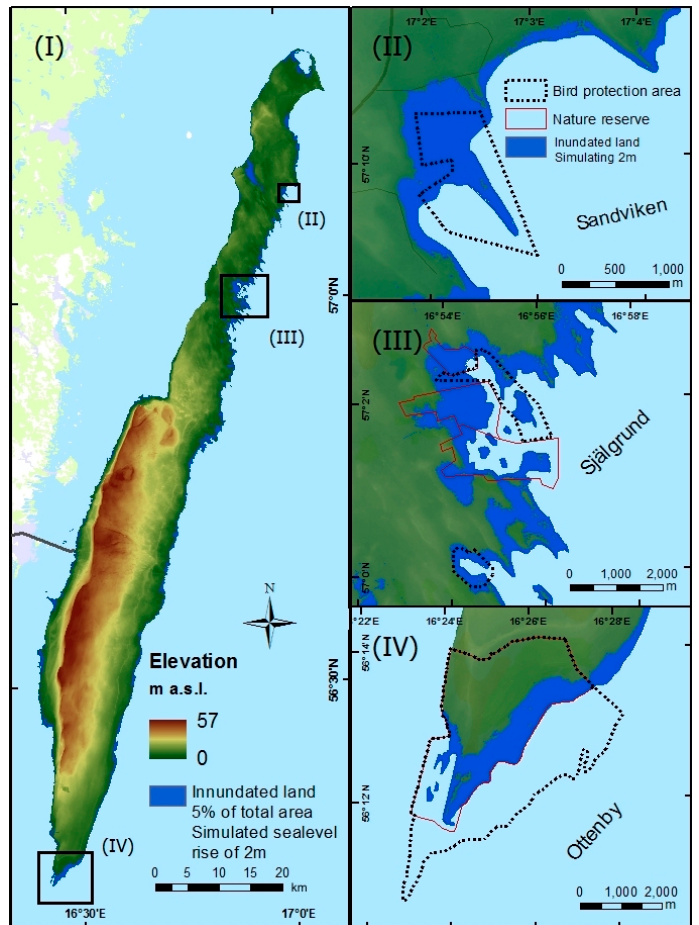
Figure 4. ( I ) Topography and inundated land area by a projected 2 m future sea level rise. ( II ) The bird protection area of Sandviken will be completely inundated and submerged. ( III ) The bird protection area of Själgrund will be lost, and the nature reserves around it will be almost entirely inundated. The new coastline will reach up to 1 km inland. ( IV ) The southern headland of Ottenby is an important area for migratory bird populations and other natural and cultural values. A large part of this region will be submerged. Some new islands will be cut off from the